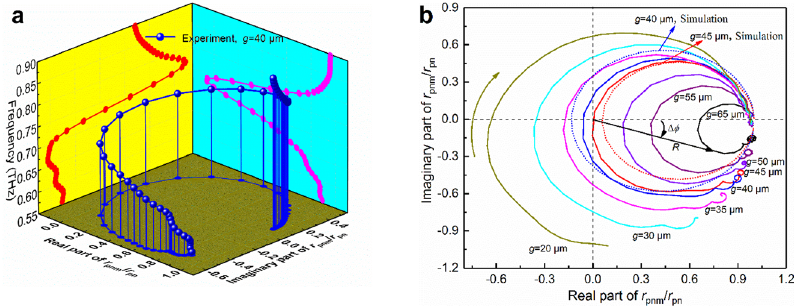
Figure 4: Parametric plot of experimental complex reflective coefficient rpnm/rpn at SPRfor variouscouplinggaps. (a) 3D plot of the variation of complex reflective coefficient rpnm/rpn obtained from experimental results with frequency for g = 40 μ m and (b) variation of complex re fl ective coef fi cients rpnm/rpn against frequency change from 0.55 THz to 0.9 THz for different gaps on a complex plane. The solidlinescalculatedfromtheexperimental data, and the dashed lines represent the simulated